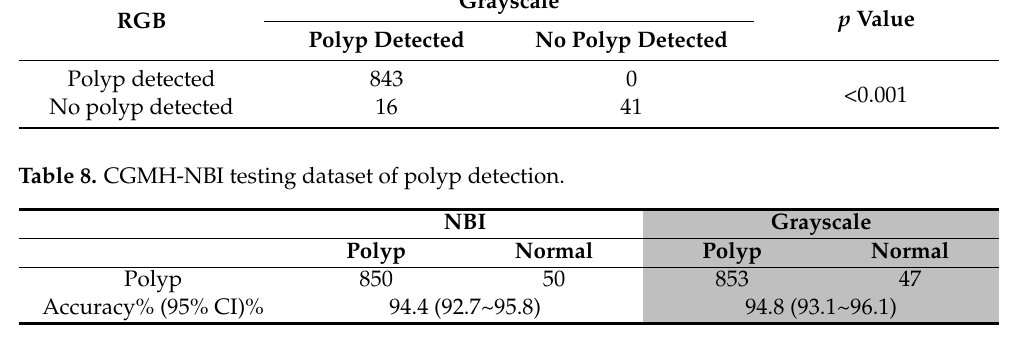
Table 9. Comparison of polyp detection between NBI and grayscale images with CGMH-NBI testing dataset.